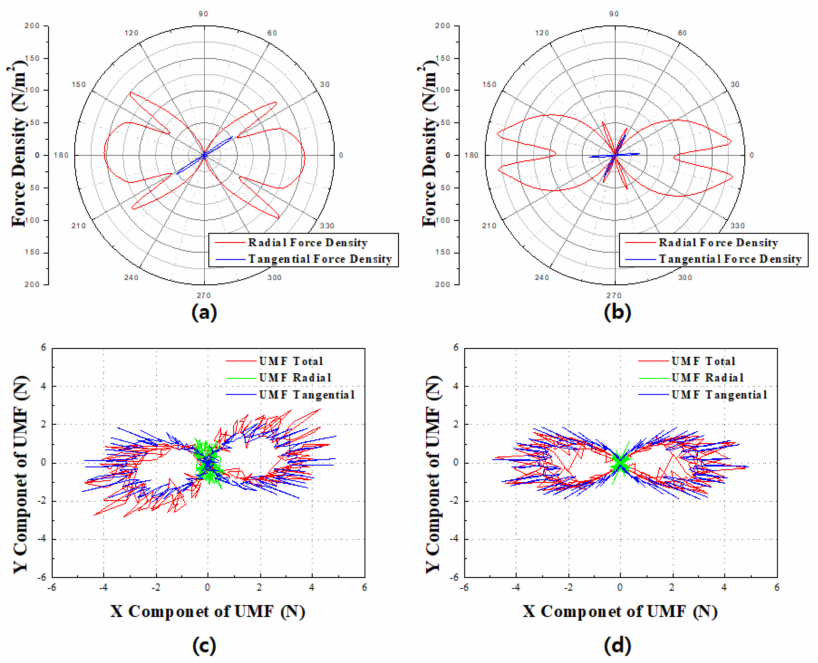
Figure 3. MPF analysis results according to ( a ) concentrated winding and ( b ) distributed winding and UMF analysis results according to ( c ) concentrated winding and ( d ) distributed